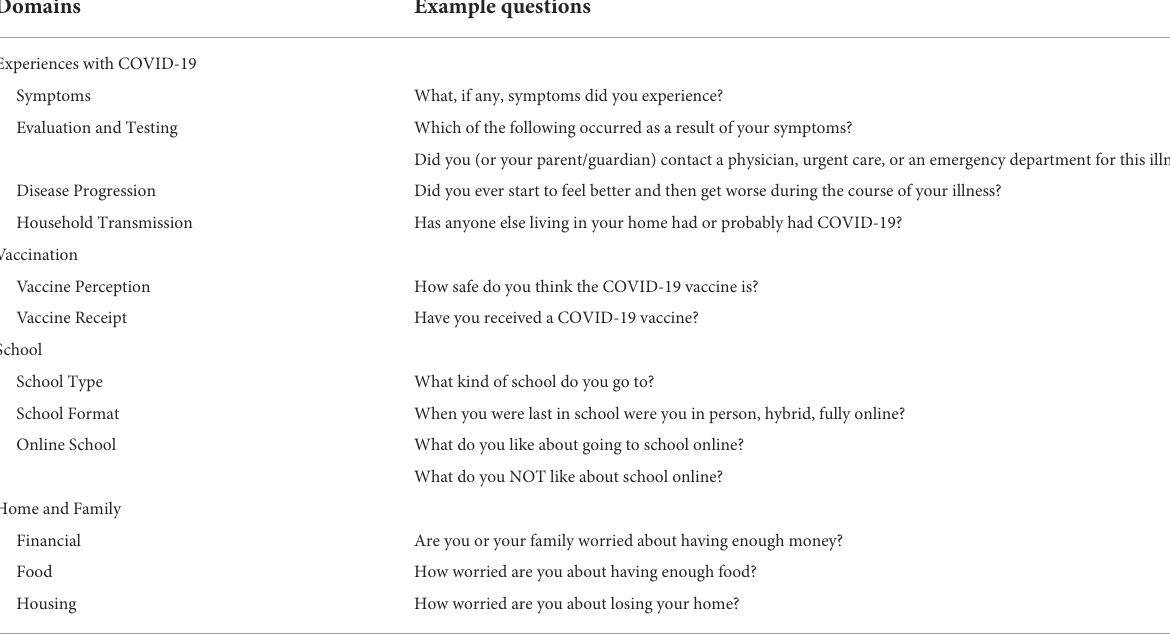
TABLE 1 Investigative team developed survey items for the CoVHORT Children and Teens Study, participants 12–17 years of